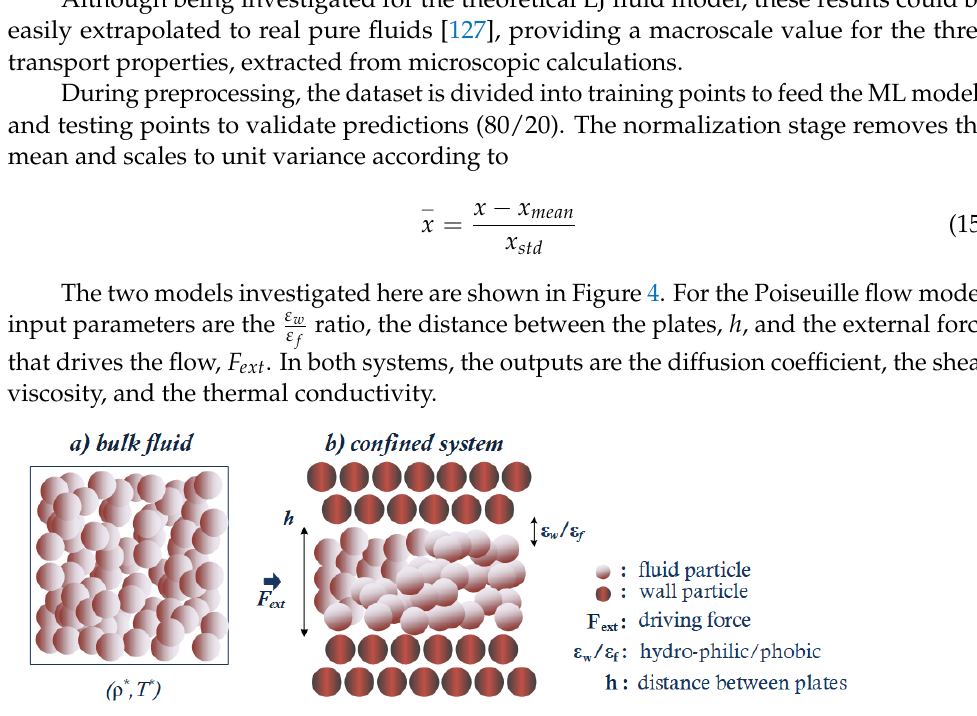
Table 1. Metrics and comparison of 12 ML algorithms for the datasets corresponding to simulation indicate the best metrics achieved for each dataset.